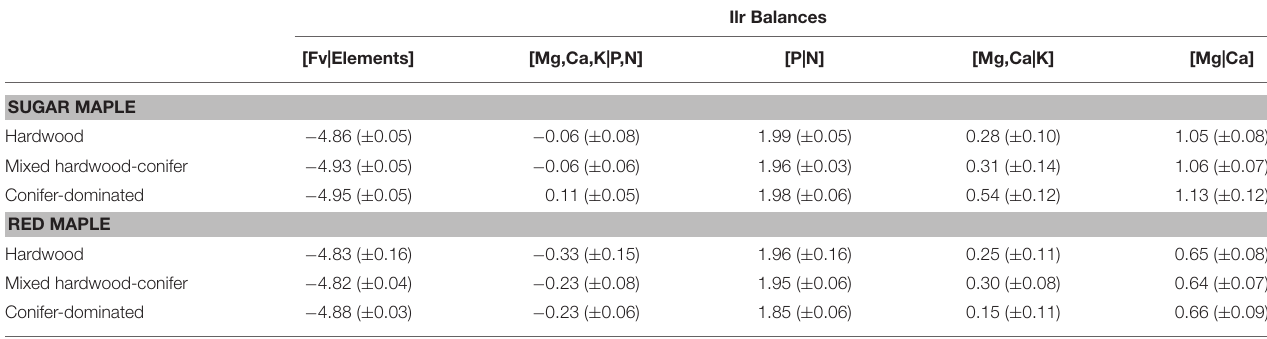
TABLE 3 | Mean foliar ilr balances of sugar maple and red maple seedlings among forest types.